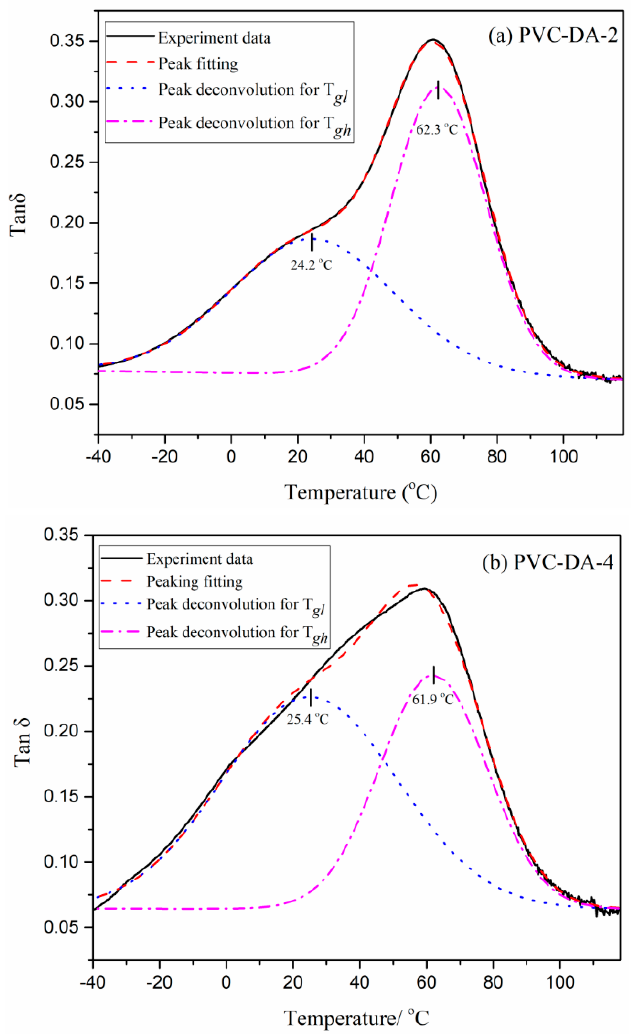
Figure 5. ( a ) Curve deconvolution results of PVC-DA-2. ( b ) Curve deconvolution results of PVC-DA-4. Table 1. Thermal and mechanical properties of PVC-DA-2n and PVC ‐ DOTP.